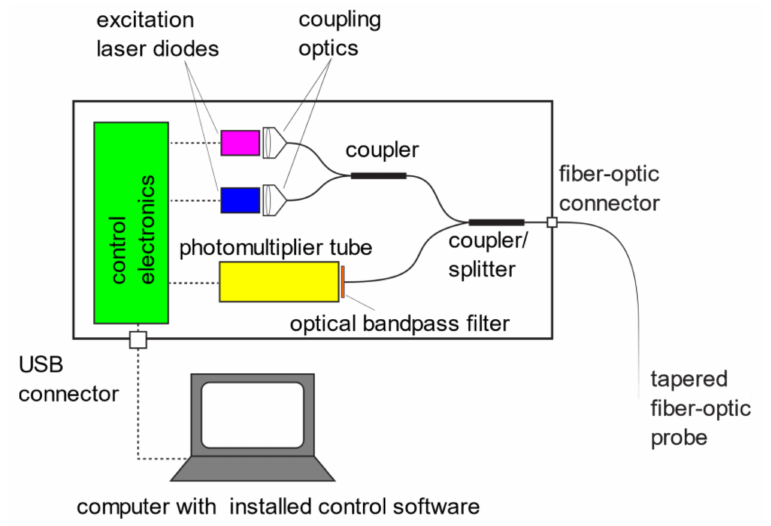
Figure 2. The scheme of the fiber-optic pH sensor